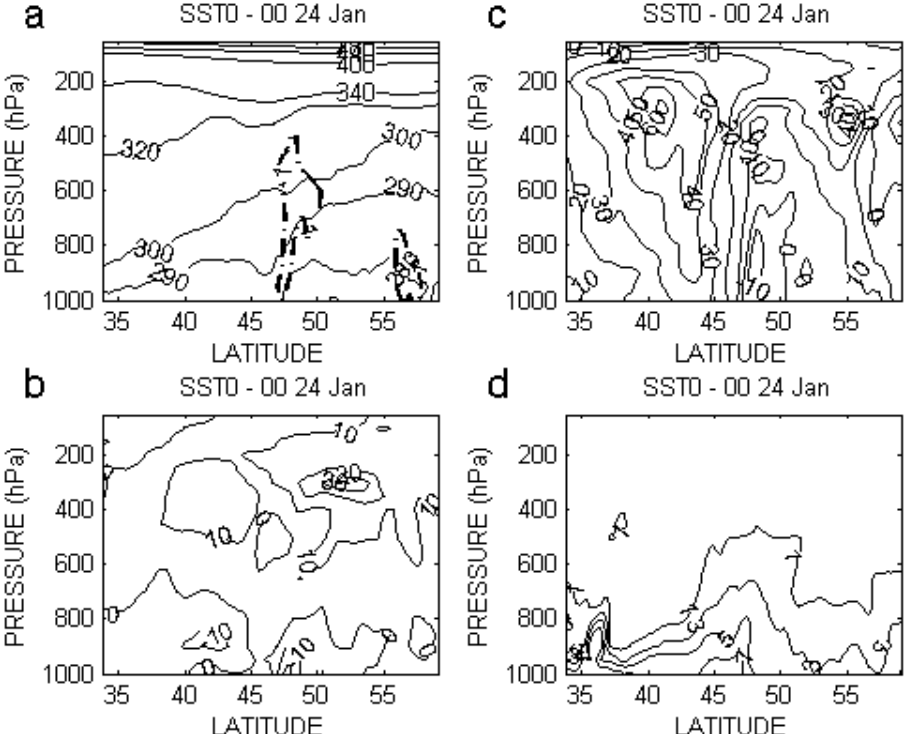
Figure 8. Vertical cross section along the meridional direction (see Figure 7) of potential temperature (solid line) [ K ] and vertical velocity (omega) (dashdot line) [ Pa s -1 ] (a), wind zonal component (b) and wind meridional component (c) [ m s -1 ] and specific humidity [ g kg -1 ] (d) at 00 UTC 24 for the experiment